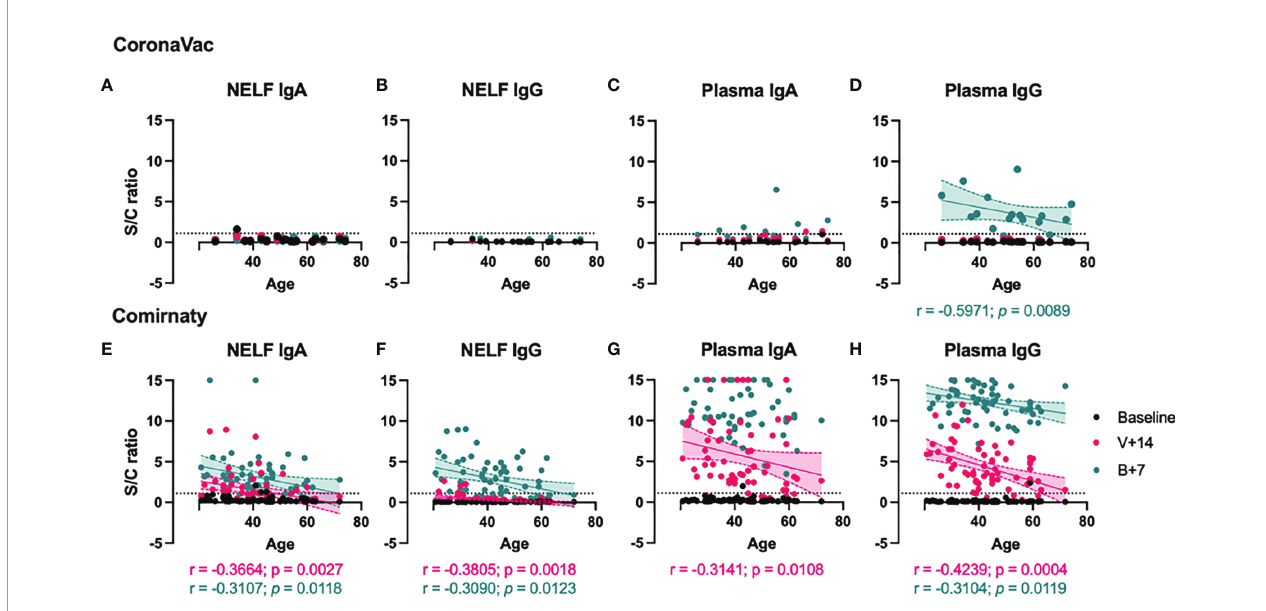
FIGURE 3 | Correlation between S1-speci fi c Igs to the age of the vaccinated subjects. The SARS-CoV-2 S1-speci fi c antibody levels in the nasal epithelial lining fl uid (NELF) (A, B, E, F) and plasma (C, D, G, H) samples detected at baseline, 14 ± 2 days after the fi rst dose (V+14), and 7 ± 2 days after the booster (B+7) time points are plotted against the age of the vaccine recipients. Signi fi cant correlations are denoted with the Spearman r and the p -value. Pink and green dotted lines represent signi fi cant linear regression fi ts with 95% con fi dence intervals (shaded region with the corresponding colors). Sample/calibrator ≥ 1.1 is regarded as the threshold of a positive sample, indicated by the horizontal dotted